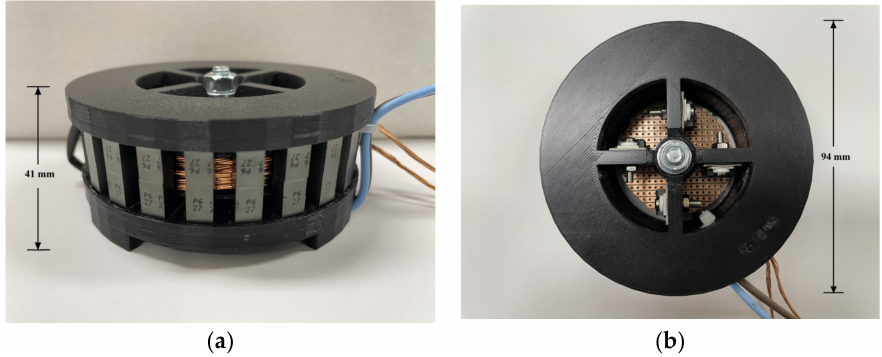
Figure 16. Physical structure of the prototype I-SiC-HFT. ( a ) Side view ( b ) Top